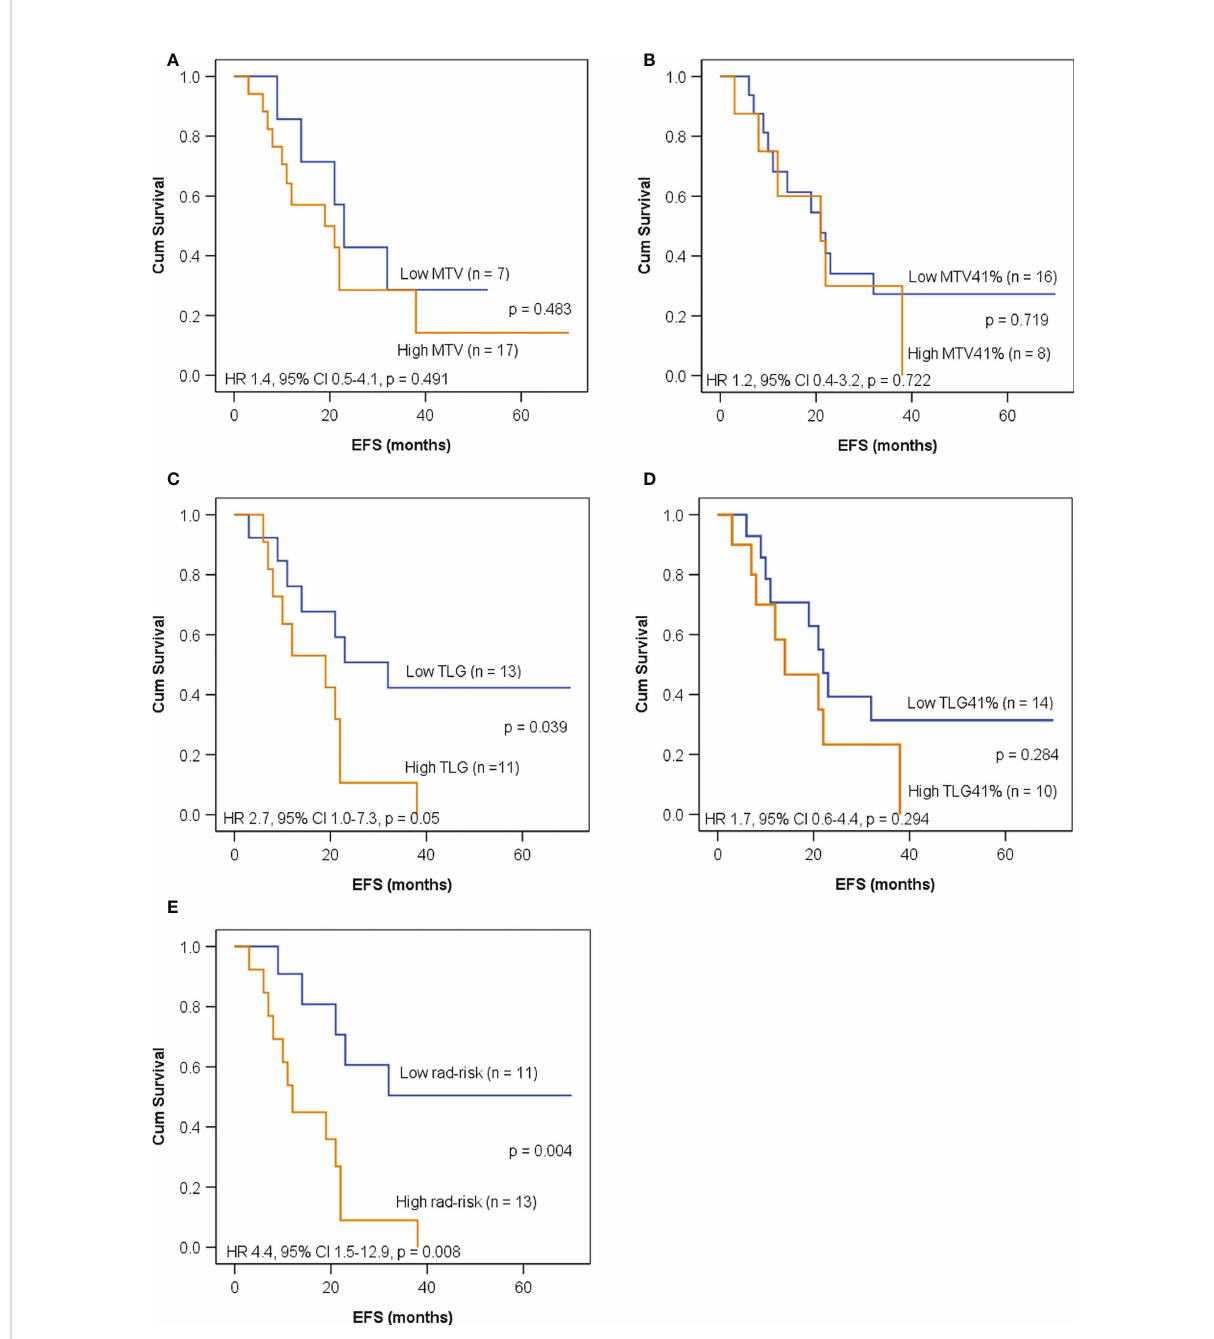
FIGURE 5 Kaplan – Meier curves for EFS in children with high-risk neuroblastoma in the test set according to (A) MTV with a cutoff value of 120 ml; (B) MTV41% with a cutoff value of 65 ml; (C) TLG with a cutoff value of 426 g; (D) TLG41% with a cutoff value of 141 g; (E)